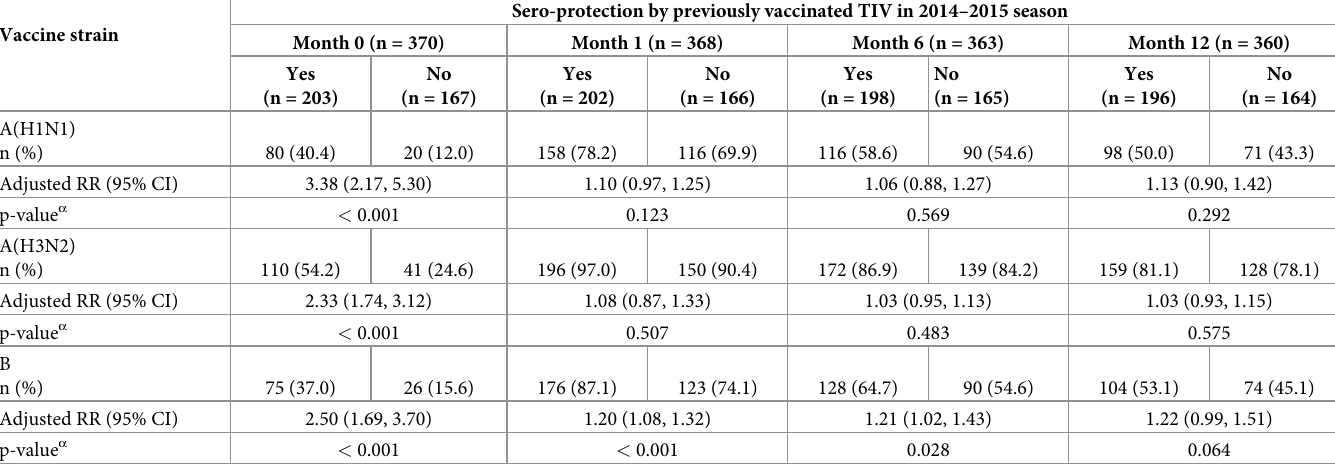
RR = relative risk. CI = confidence interval α Log-binomial regression adjusted for age group and sex. Significance level at <